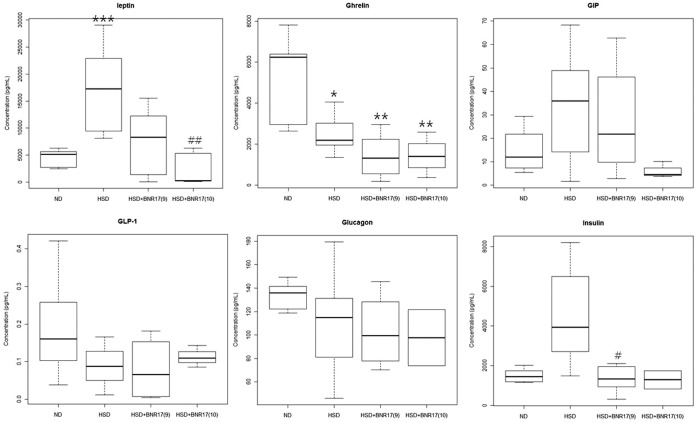

L. gasseri BNR17 affects endocrine hormones.C57BL/6J mice were given ND, HSD, or HSD containing BNR17 (109 or 1010 CFU) for 10 weeks. Serum was obtained by centrifugation of whole blood and analyzed. GIP, glucose-dependent insulinotropic polypeptide; GLP, glucagon-like peptide. Data represent the means ± SD. Wilcoxon rank-sum test: *P<0.05, **P<0.01, ***P<0.001 versus the ND group; #
P<0.05, ##
P<0.01 versus the HSD group.